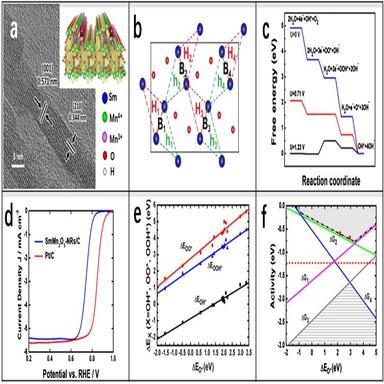
(a) HRTEM of mullite Nanowire, inset is a stepped surface(0 0 1). (b) Top view of (0 0 1) MnO surface layer. (c) Free energy diagram for ORR over the stepped surface at different potentials. (d) LSV curves of Pt/C and mullite in O2-saturated 0.1 M KOH at a rotating speed of 1600 rpm with a scan rate of 5 mV/s. (e) The linear scaling relations of binding energies of OH\ , OOH\ and OO\ versus O\ . (f) Gibbs free energy versus O\ binding energy difference. Reproduced with permissions from Refs. .